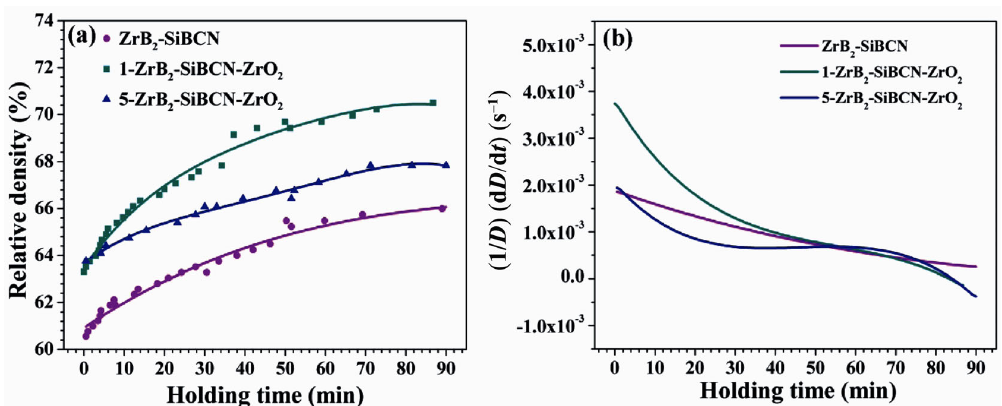
Fig. 10 (a) Densification and (b) densification rate of ZrB 2 –SiBCN ceramics with different contents of ZrO 2 at soak temperature of 1300 ℃ for around 90